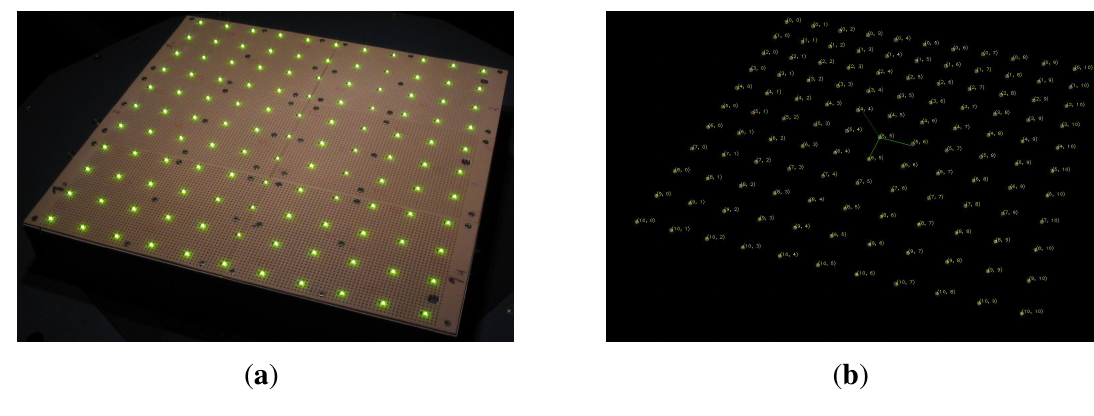
11 LED Figure 12. Geometric calibration for the Dome 1 device: (a) shows the 11 × calibration target under room light (for illustration purposes). (b) shows a picture taken under calibration conditions with annotation of automatically detected features. The LEDs are aligned on a stripboard in a regular grid with a horizontal and vertical distance of 27 . 94 mm , 28 cm . We assume the stripboard to be manufactured spanning a total square of 28 cm × sufficiently accurate for our purpose. Pictures taken from